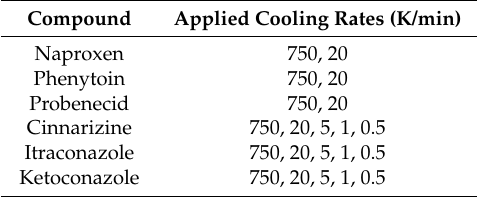
Table A1. Applied cooling rates during melt quenching to determine GFA class.